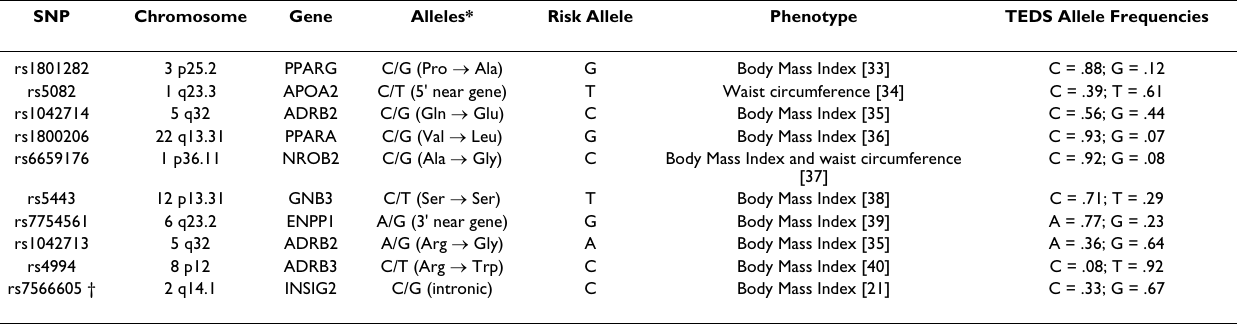
Table 1: Selected candidate